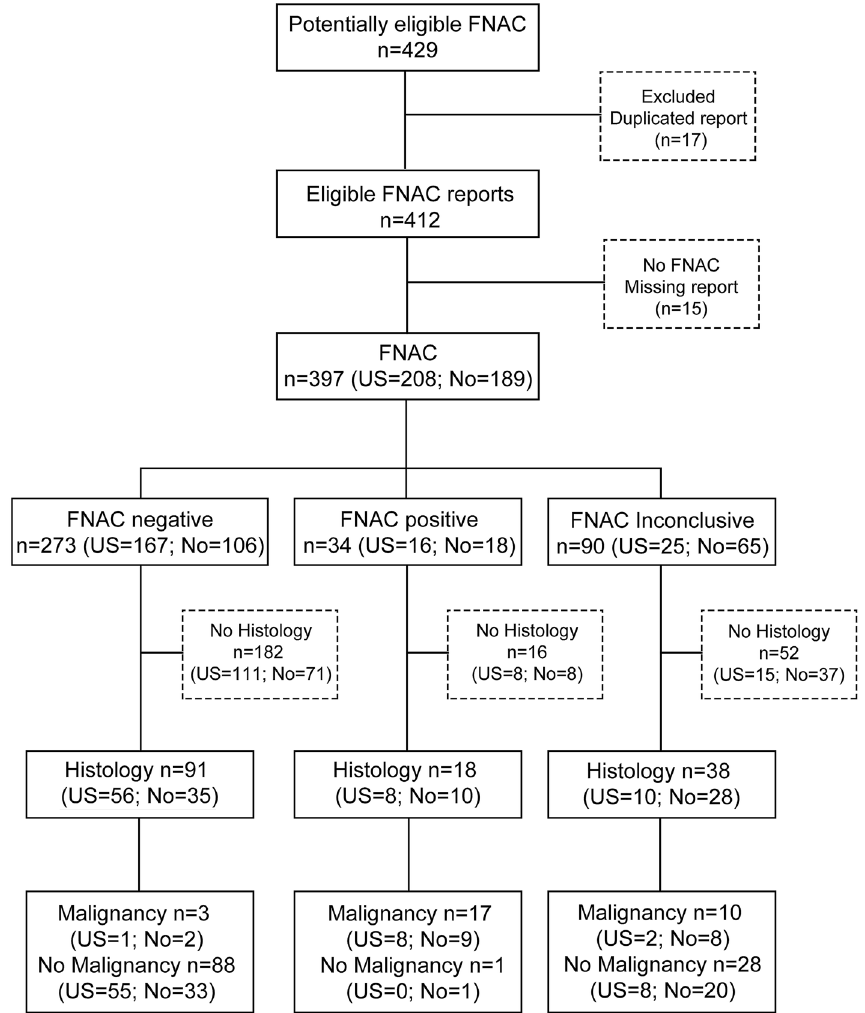
Fig. 1 STARD diagram reporting flow of participants through the